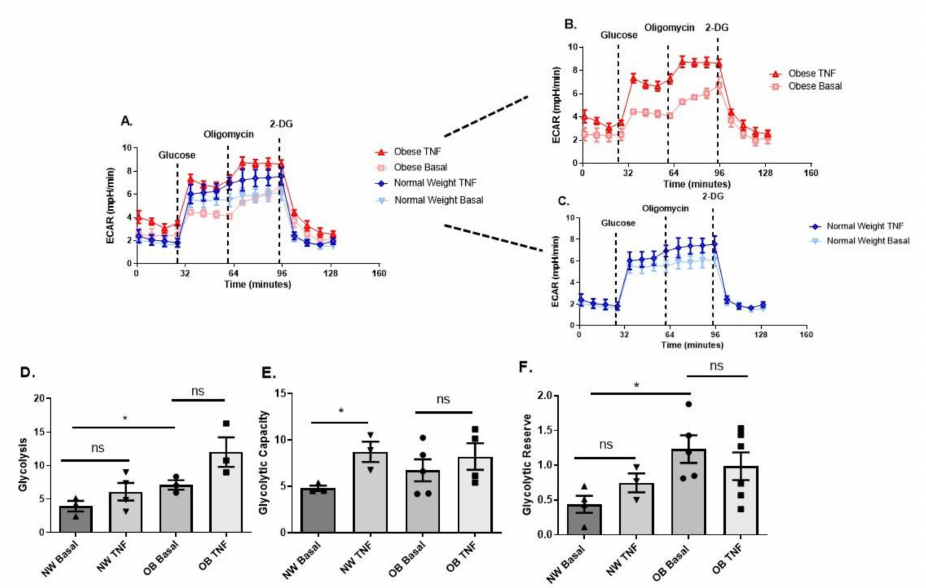
Figure 4. Obese and normal-weight OA synovial fibroblasts exhibit differential glycolytic metabolism. ( A – C ) OA synovial fibroblasts from obese patients (n = 6 patients) stimulated with TNF α at 10 ng/mL for 24 h show elevated aerobic glycolysis, compared to stimulated and unstimulated OA synovial fibroblasts from normal weight (n = 6 patients, with 5 biological replicates per patient). ( D ) Glycolysis levels are significantly increased in obese OA synovial fibroblasts when stimulated with TNF α at 10 ng/mL for 24 h. ( E ) Glycolytic capacity of normal weight OA synovial fibroblasts is elevated when challenged with TNF α at 10 ng/mL for 24 h. ( F ) Glycolytic reserve is increased in unstimulated obese OA synovial fibroblasts, compared to unstimulated normal weight OA synovial fibroblasts. All data presented as mean ± SEM. * = p <